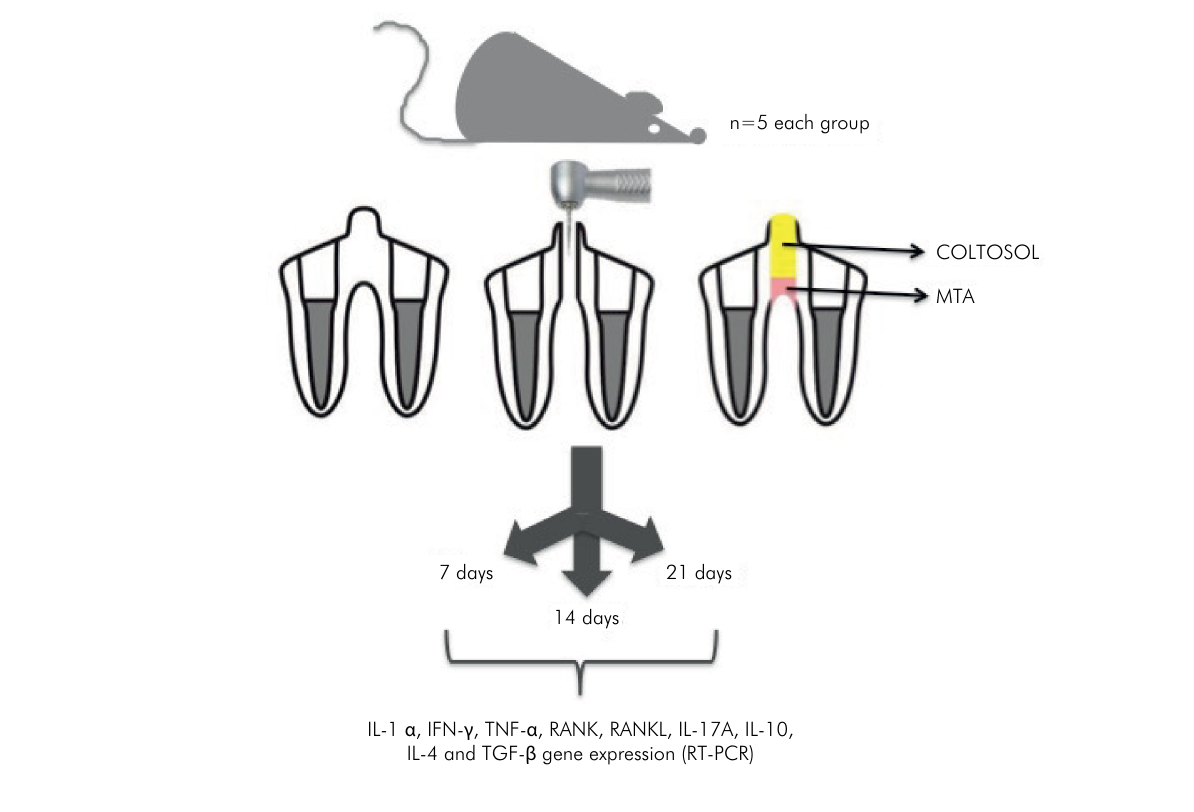
Figure 1. Germ free mouse model of experimental furcation perforation: schematic representation of the treatment